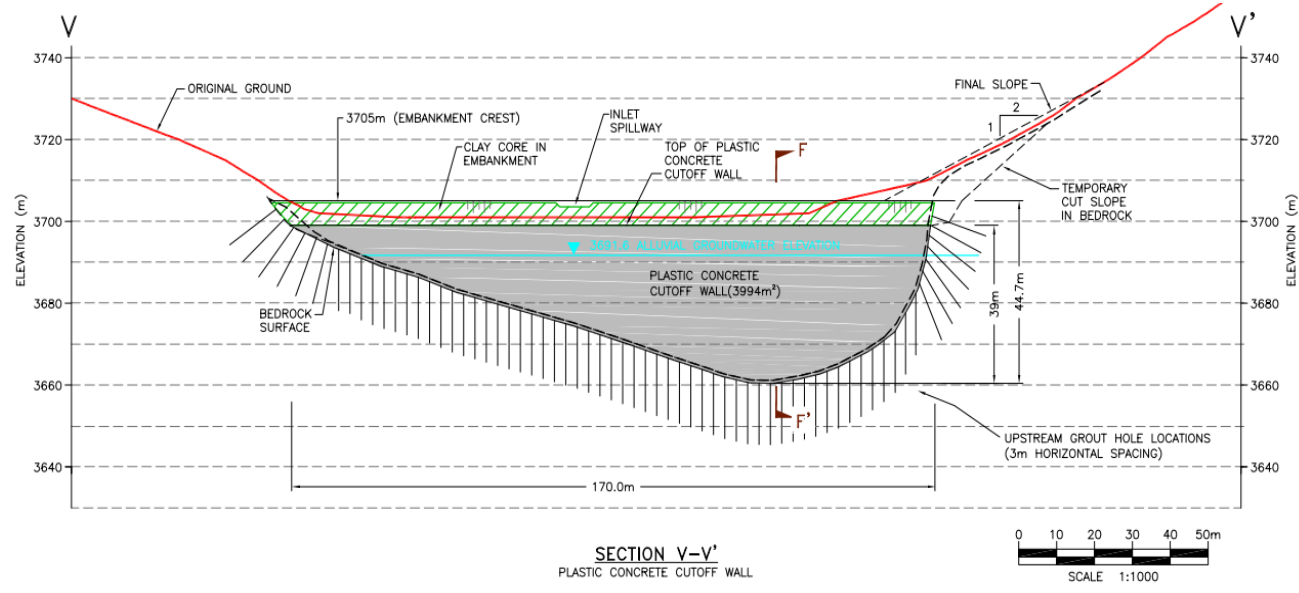
Figure 8. Example of plastic concrete slurry wall–grout curtain system in TSF dam.